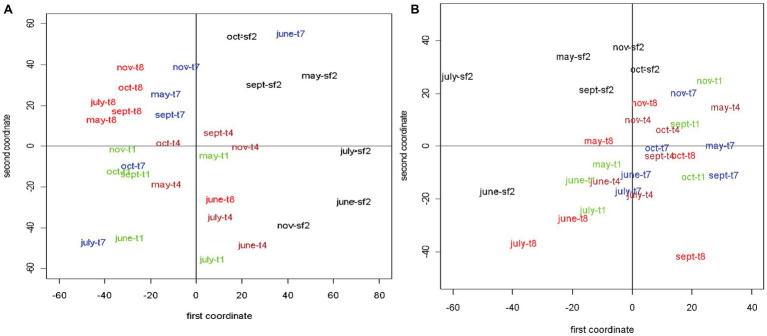
Multidimensional scaling (MDS) plots of the dissimilarity matrices based on the randomly amplified polymorphic DNA-polymerase chain reaction (RAPD-PCR) fingerprints for free extracellular (A) and mitomycin-C (mitC)-inducible viruses (B). For ease of comparison, the five types of management sites are color-coded. The stress values associated with the two MDS are both less than 0.2. The land management treatments are the same as described in Figure 1.